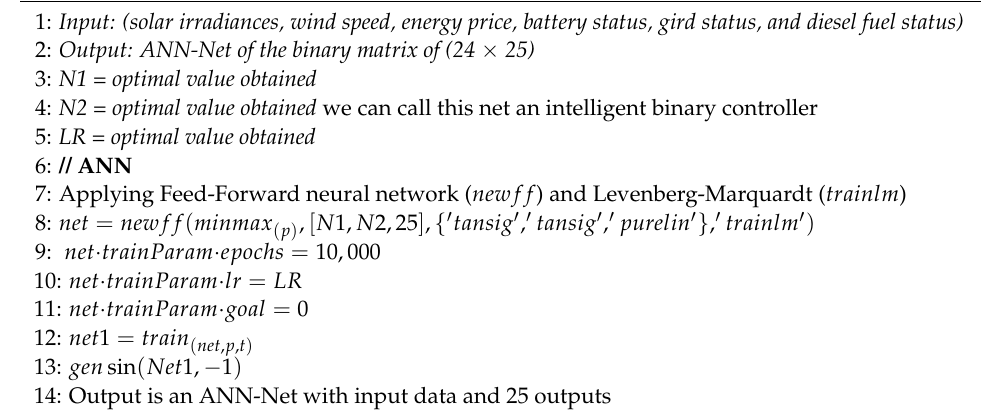
Algorithm 1. Pseudocode of ANN training based on optimized parameters obtained from optimization algorithms.